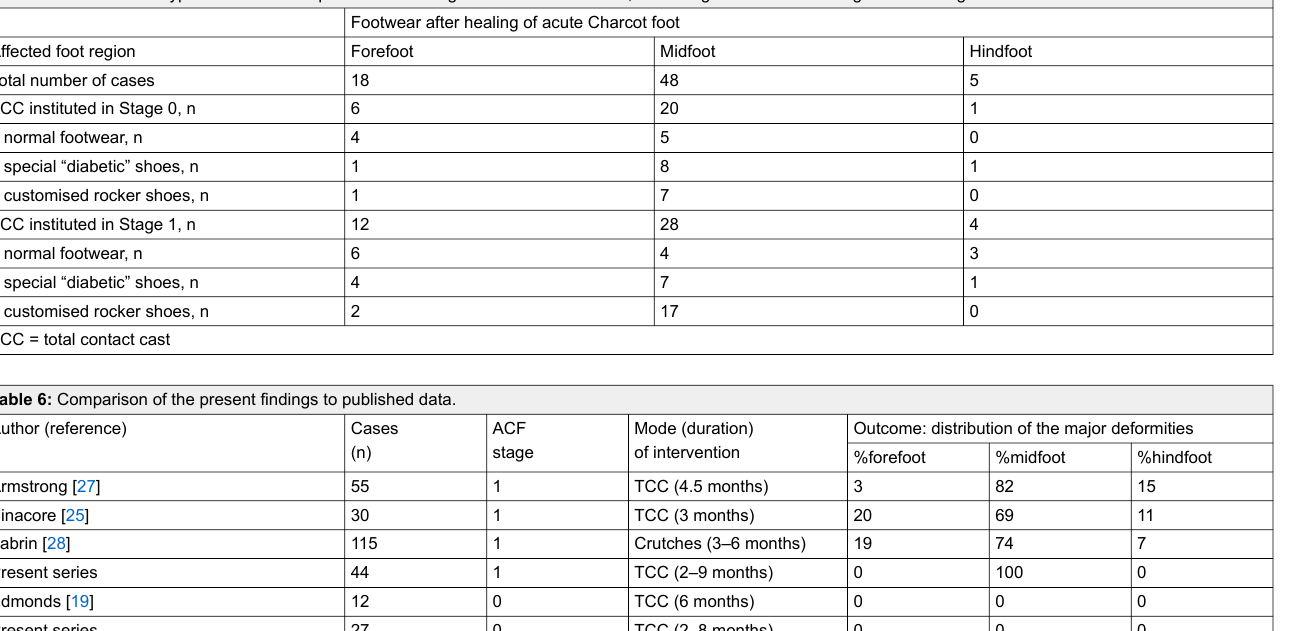
Table 5: Distribution of types of footwear required after healing the acute Charcot foot, according to Charcot foot stage and foot region affected.